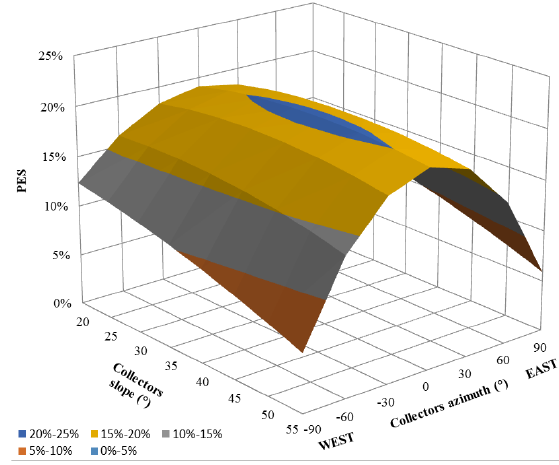
Figure 7. Primary energy saving of the alternative system (AS) (Scenario A) with 0% of solar thermal energy surplus used and evacuated tube collectors as a function of azimuth and tilt angle.